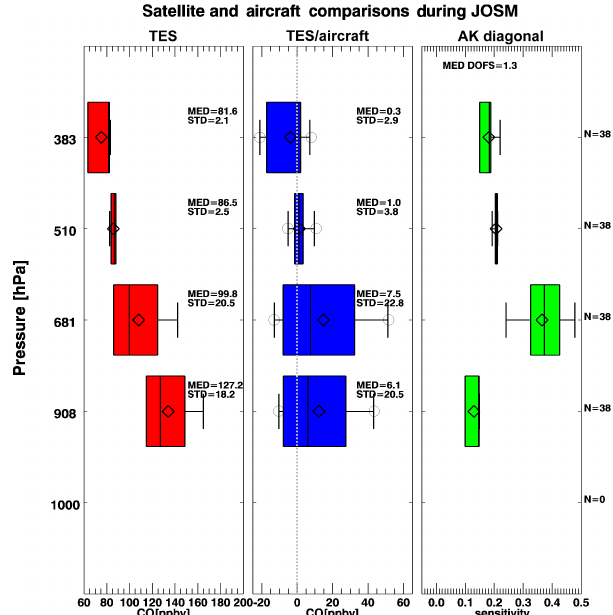
Figure 6. Summary box-and-whisker plots of the satellite and air- craft comparisons during JOSM for CO, with the same plotting con- vention as Fig.